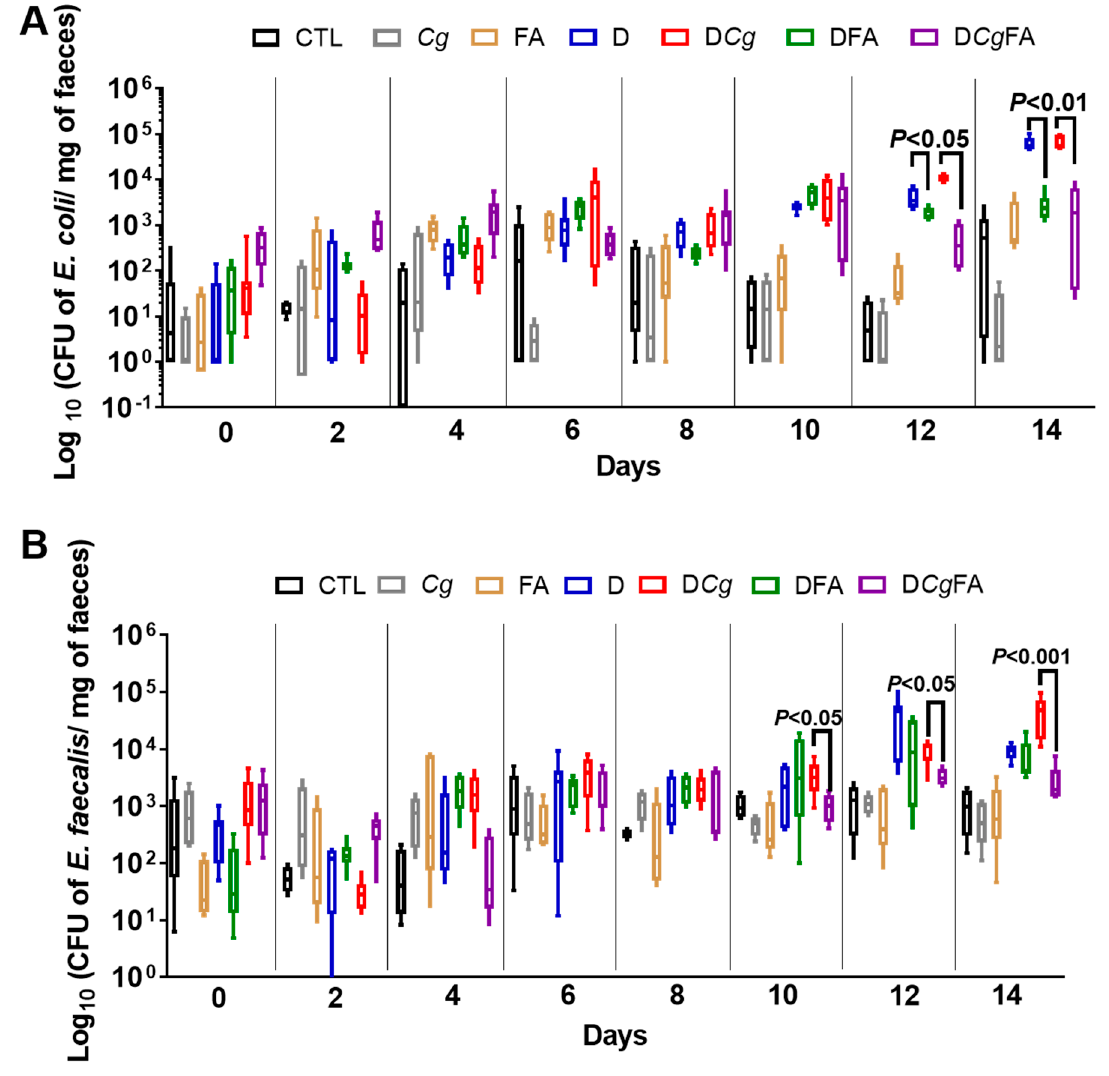
Figure 9. Cultivable E. faecalis and E. coli after fatty acid (FA) treatment in mice with DSS-induced colitis. ( A ) Number of E. coli colony–forming units (CFUs) recovered from stool samples. ( B ) Number of E. faecalis CFUs recovered from stool samples. Stool bacteria were isolated from mice on day 0 before C. glabrata , DSS challenge, and FA treatment. The seven groups consisted of controls (CTL; water), C. glabrata alone ( Cg ), oleic and palmitic acids alone (FA), DSS alone (D), DSS + oleic and palmitic acids (DFA), DSS + C. glabrata (D Cg ), and DSS + C. glabrata + oleic and palmitic acids (D Cg FA). Data are the mean ± SD of six mice per group.